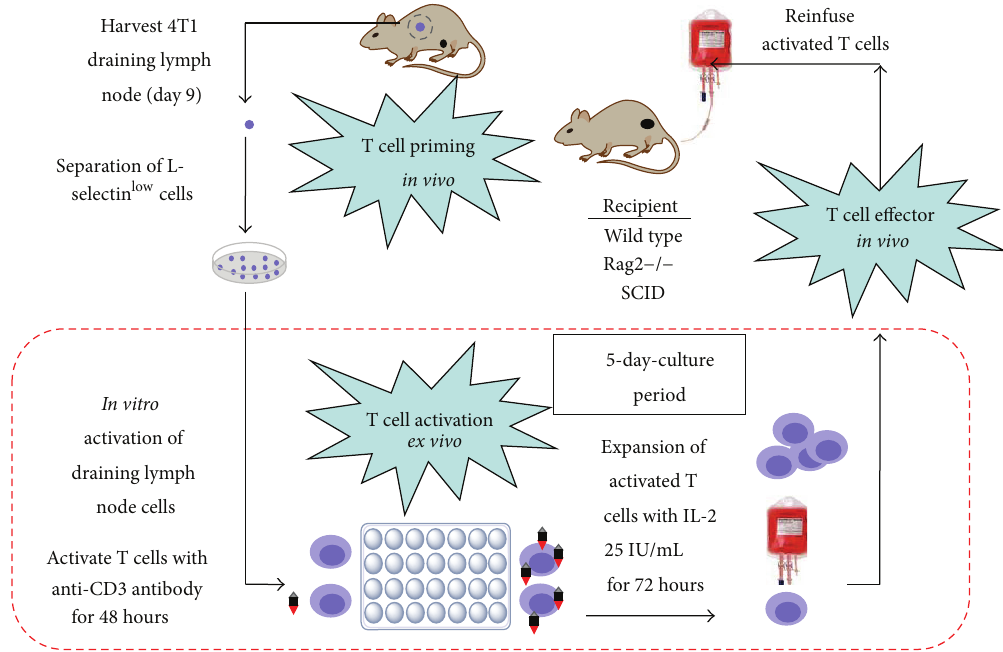
Figure 1: Tumor vaccination, T cell activation, and adoptive